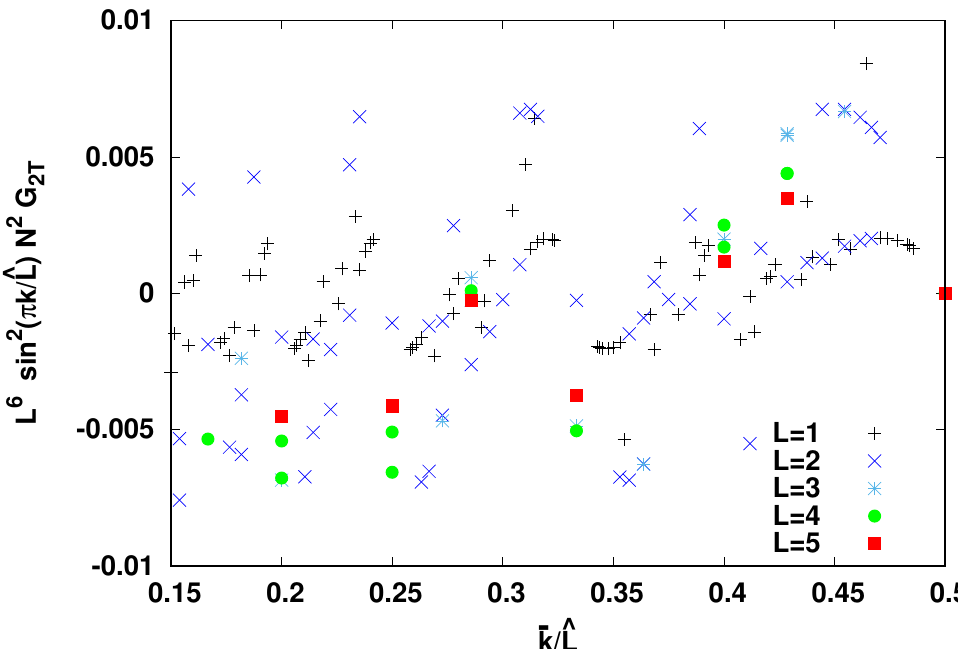
Figure 7. The function L 6 N 2 sin 2 ( (cid:25)k= ^ L ) G 2 T ( L ) for the plaquette is plotted as a function of (cid:22) k= ^ L .